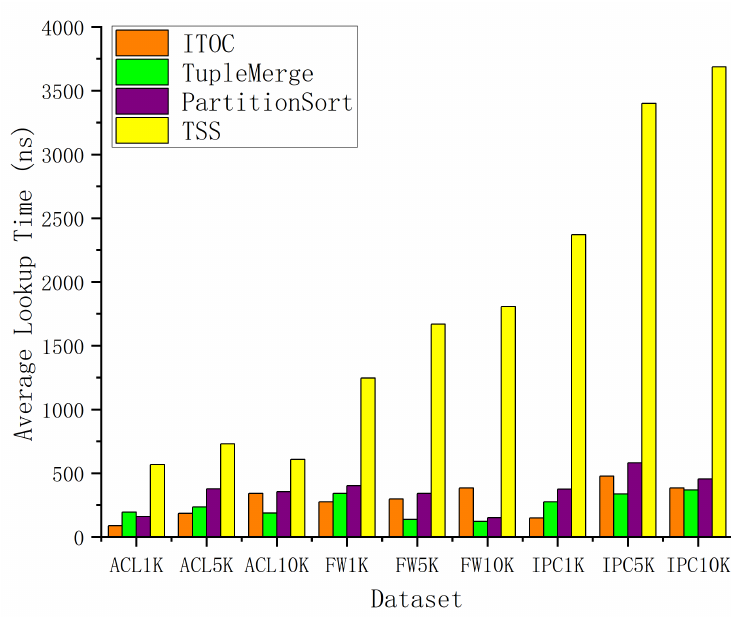
Figure 6. Lookup performance comparison.